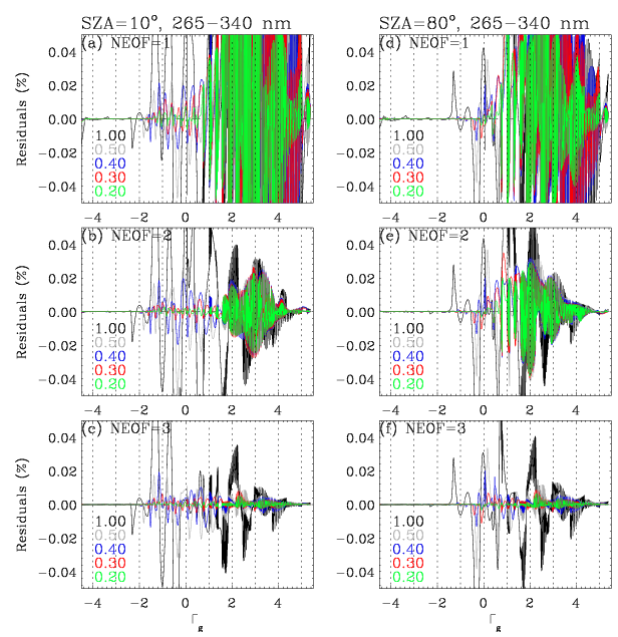
Figure 4. Residuals (%) of the PCA-RT radiance in the wavelength range 265–340nm compared to the exact-RT calculations, for dif- ferent binning steps (different colors) and number of EOFs. Results are plotted as a function of (cid:48) g (logarithm of the total gas optical depth); VZA = 30 ◦ and AZA = 120 ◦ for SZAs of (a, b, c) 10 ◦ and (d, e, f) 80 ◦ ,